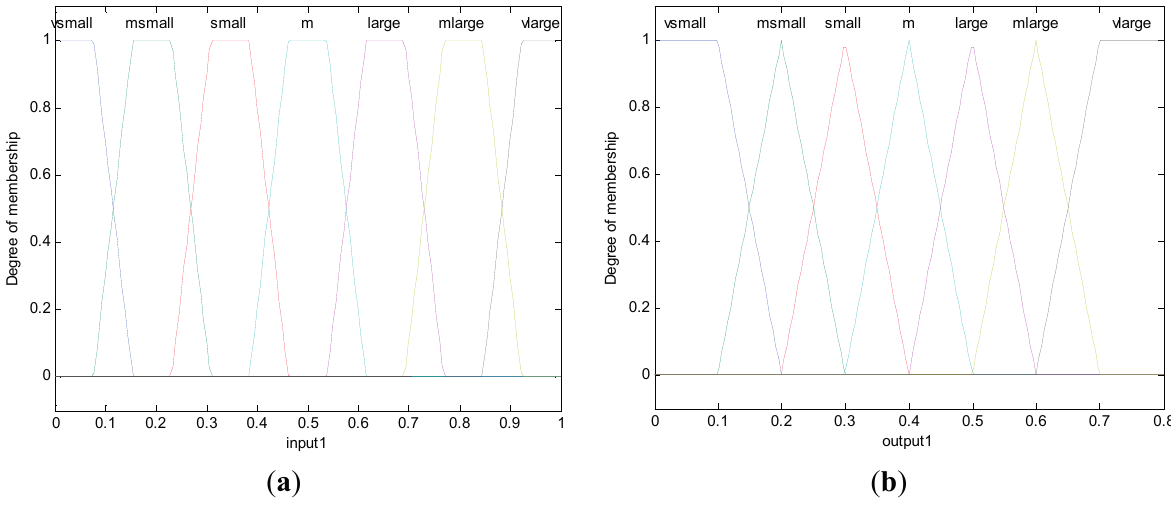
Figure 3. The principle of the fuzzy inference system.